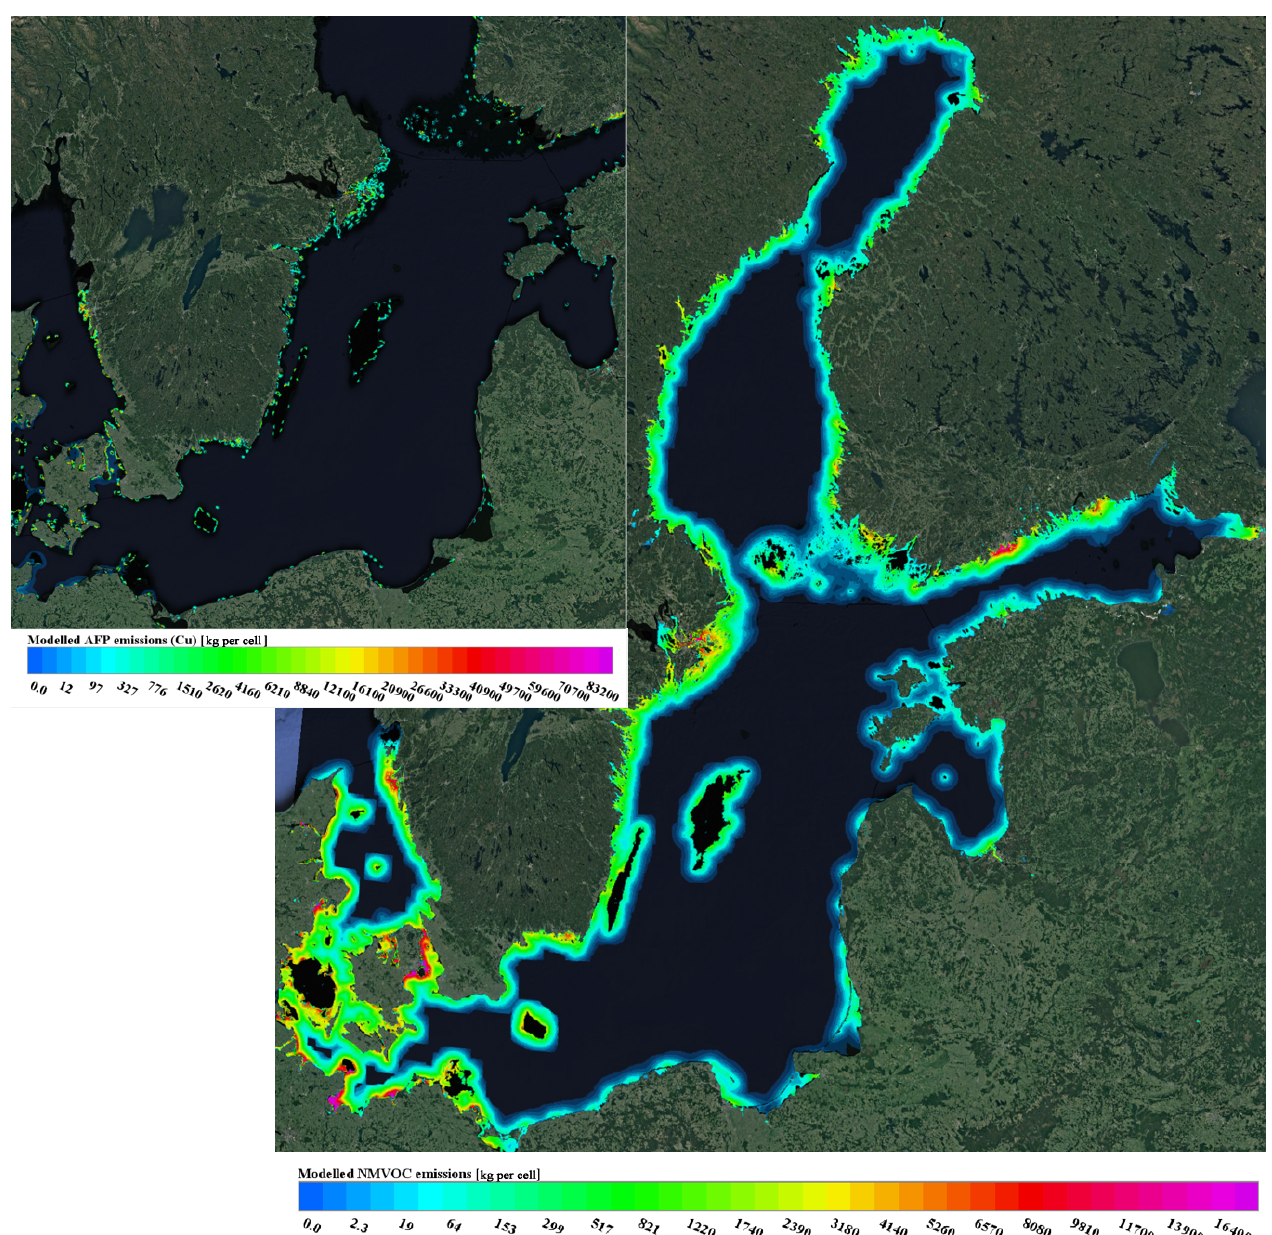
Figure 8. Estimated geographical distribution of NMVOC exhaust emissions and the copper emissions from antifouling paints for a selected area. Satellite image background provided by © Google